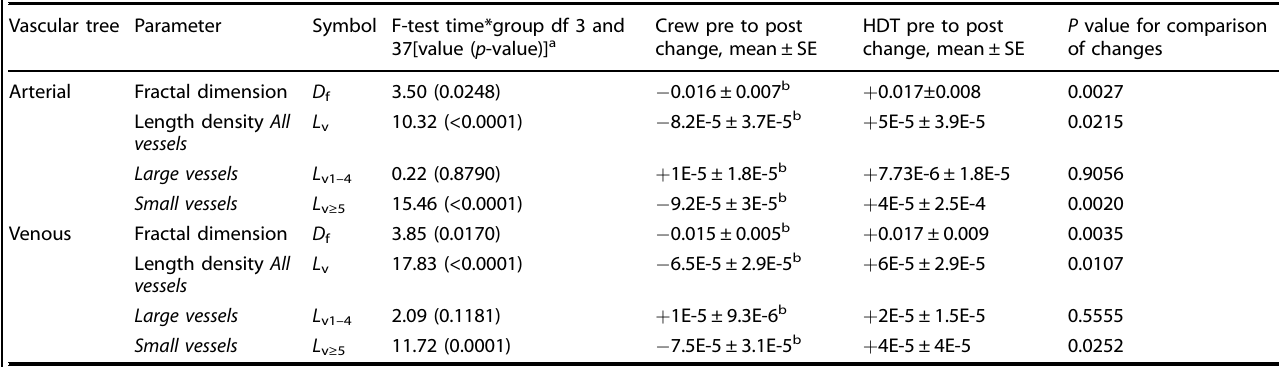
Table 1. Comparison of change in arterial and venous density in retinas of 6° HDT subjects and ISS crew members. Vascular tree Parameter